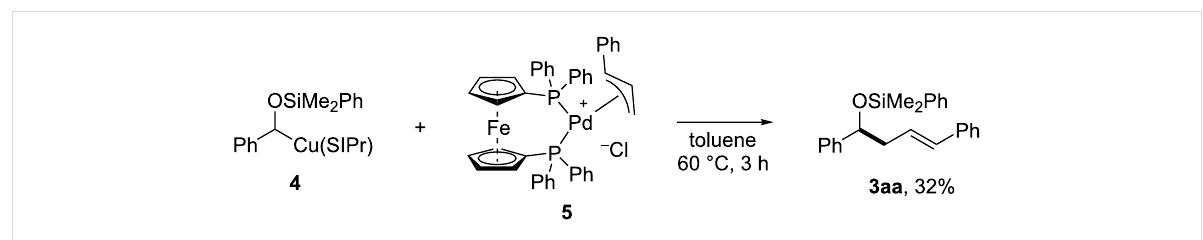
Scheme 4: Stoichiometric reaction.